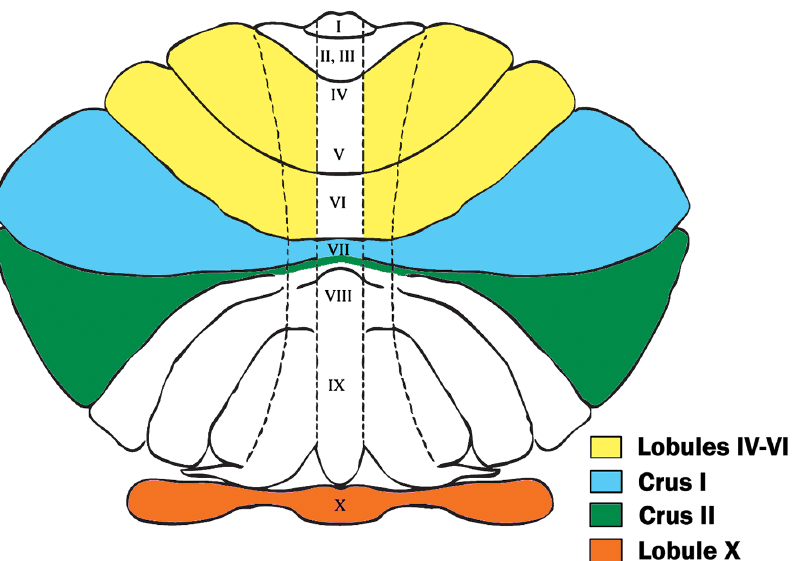
Figure 1. Cerebellar Regions Investigated. This flatmap diagram displays the four cerebellar regions of interest for our stereological assay. Hemispheric lobules IV–VI (in yellow) are bordered by the preculminate and superior posterior fissures, lateral to the fourth ventricle. Crus I (in blue) is the region bordered by the superior posterior and horizontal fissures. Crus II (in green) is bordered by the horizontal and ansoparamedian fissures. Lobule X, the flocculonodular lobe (in orange), is bordered by the posterolateral fissure. This image is an adaptation of the diagram by Larsell,